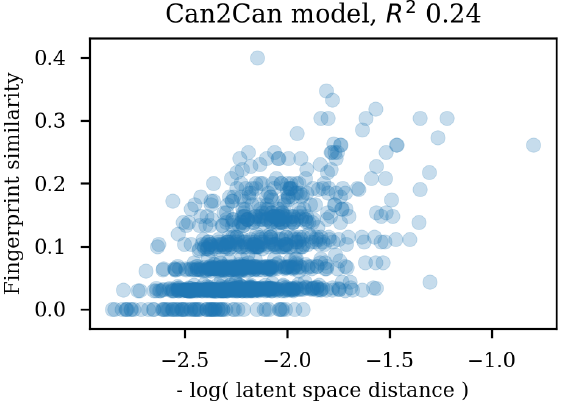
Figure 4. Scatter plot of the latent space similarities and the alignment scores of the SMILES strings.